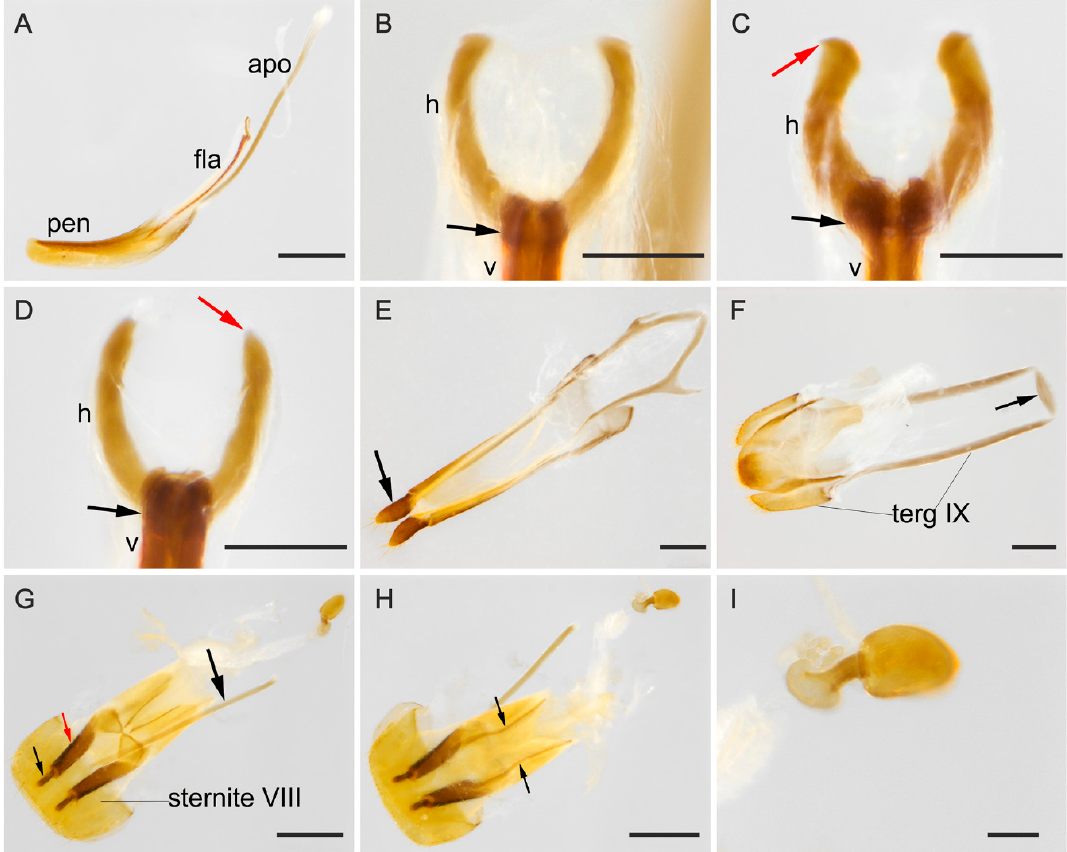
Figure 5 . ( A – F ) Male abdominal terminalia of Mycotretus centralis Arrow, 1909 from different localities: ( A – B , E – F ) Paralectotype from San Jerónimo, Guatemala; ( C ) Campo Bom, RS, Brazil; ( D ) Carazinho, RS, Brazil. ( A ) Lateral view of the aedeagus, showing apophyses (apo), flagellum (fla) and penis (pen). ( B – D ) Dorsal view of flagellum showing its head (h) and anterior tip of virga (v); black arrows showing the strongly sclerotized connection between virga and head; red arrow (in C) showing the small and narrow denticle at the outer apical edge of head and (in D) showing the blunt and narrowed tip. ( E ) Tegmen, arrow showing parameres; ( F ) abdominal segments IX–X: laterotergite IX (terg IX), arrow showing the sclerite at the anteroventral edge of segment IX. ( G – I ) Female abdominal terminalia of a specimen from Piraí, RJ, Brazil: ( G ) dorsal view, with small black and red arrows showing a gonostylus and a gonocoxite, respectively; big black arrow showing the median strut of sternite VIII; ( H ) ventral view, arrows showing baculi of paraprocts; ( I ) spermatheca. Scale bars: A , G – H = 0.5 mm; B – D , I = 0.1 mm; E – F = 0.2 mm.